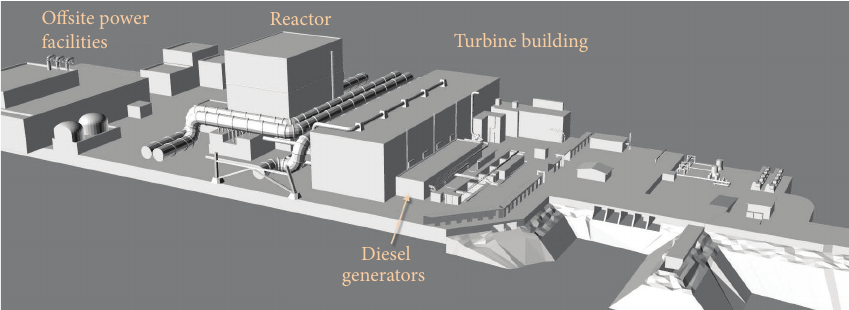
Figure 10: 3D plant model developed to simulate